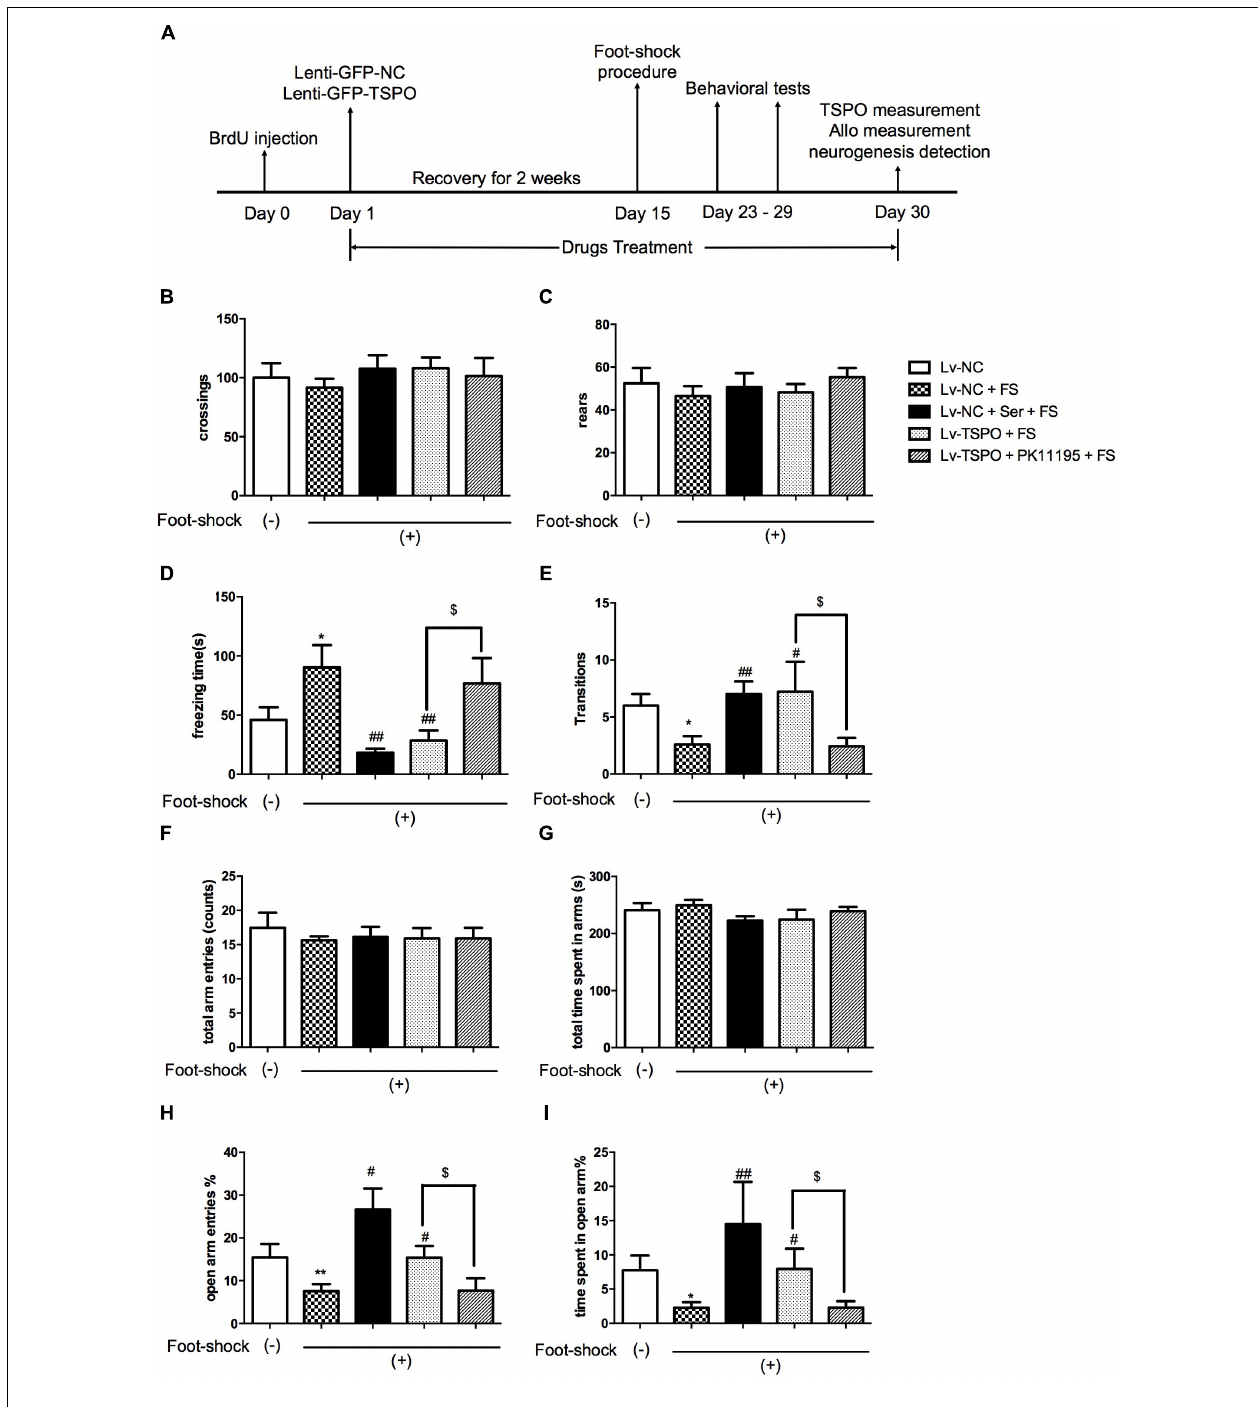
FIGURE 1 | TSPO overexpression in the DG elicited anxiolytic-like effect in the mouse exposed to electric foot-shocks. (A) Design of the experiment. Results of spontaneous locomotor activity showed no difference among groups for the number of line crossings (B) or rears (C) in the open field test. (D) The contextual freezing time was increased in electric foot-shock model group (LV-NC + FS). The freezing behavior was significantly reduced in both Lv-NC + Ser + FS and Lv-TSPO + FS groups on day 23. (E) Exposure to foot-shock resulted in less transitions in the Light–dark transition test, which was attenuated by Ser or Lv-TSPO on day 29. (F–I) No differences were observed between groups for total arm entries (F) or total time spent in all arms (G) in the EPM test on day 27. Compared to the control group, the Lv-NC + Foot Shock group showed decreased open arm entries percentage (H) and time percentage in open arms (I) . And the effects were reversed by either Ser administration or Lv-TSPO injection. All the effects of Lv-TSPO in (D,E,H,I) was blocked by PK11195. Data were presented as the means ± SEM ( n = 8–11). ∗ P < 0.05 compared with the Lv-NC+foot-shock (–) group; # P < 0.05, ## P < 0.01 compared with the Lv-NC+FS group; $ P < 0.05 compared with the Lv-TSPO+FS